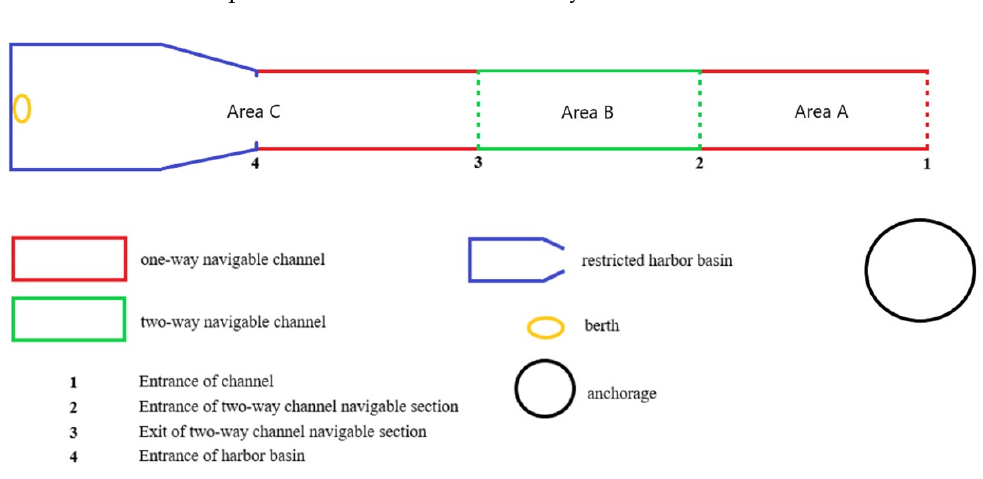
Figure 1. The constructed port layout, including an anchorage, restricted channel, and harbor basin.